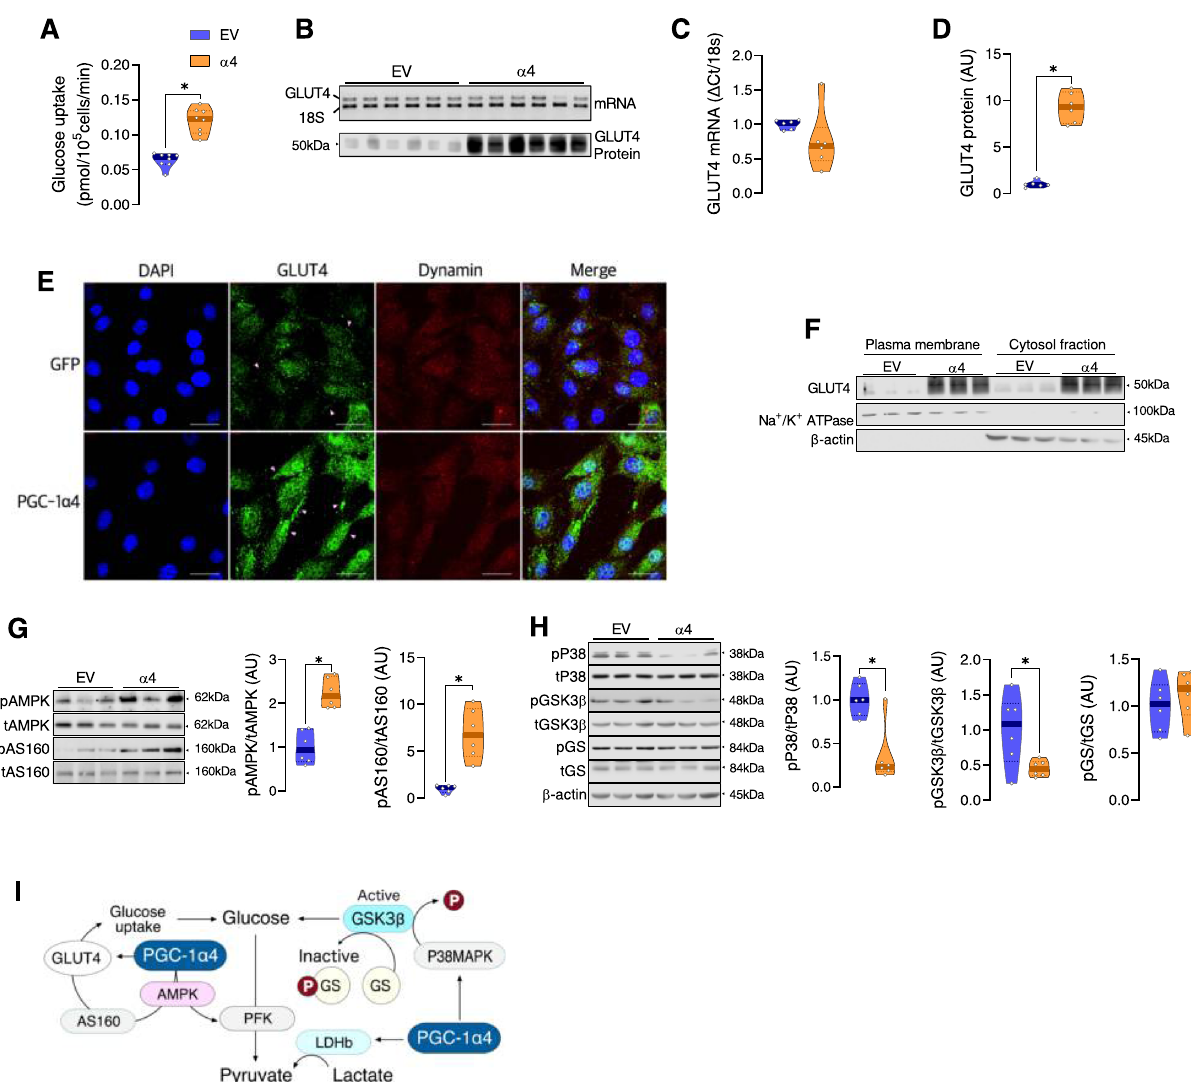
Fig. 4 PGC-1 α 4 overexpression enhances cellular glucose uptake. A Glucose uptake was assessed using a bioluminescent kit assay in myotubes transfected with an empty vector (EV) or an adenovirus overexpressing PGC-1 α 4 ( α 4) ( n = 8 per group). Unpaired two-tailed t -test was used. B – D GLUT4 mRNA was measured by semiquantitative RT-PCR, and GLUT4 protein content was measured by immunoblotting in myotubes expressing EV or overexpressing α 4 ( n = 6). Unpaired two-tailed t -tests were used. E GLUT4 antibody detection (green) and DAPI staining (blue) in cells transfected with EV or α 4 show clustering of greater GLUT4 near the dynamin-labeled (red) cell membrane in α 4 myoblasts. Experiments in panel E were repeated three times with similar results. White scale bars in each image are 30 µ m in length. F GLUT4 was measured in the plasma membrane (indicated by the presence of Na + /K + ATPase) and cytosolic (indicated by the presence of β -actin) fractions from myotubes transfected with EV or α 4 ( n = 3). G , H Representative immunoblots and quanti fi cation of phosphorylated AMPK, AS160, P38, GSK3 β , and GS in cells transfected with EV or α 4 are shown. Data are expressed as the phosphorylation of each signaling protein normalized to the abundance of its total protein content ( n = 6 per group). Unpaired two-tailed t -tests were used. I Diagram of the hypothetical role of PGC-1 α 4 in glucose metabolism in muscle cells. PGC-1 α 4 enhances signaling and transport machinery to bring glucose into the cell, as well as the glycolytic enzymes necessary for metabolizing glucose. Further, inhibition of key signaling events involved in glycogen synthesis by PGC-1 α 4 suggest a favorable role of PGC-1 α 4 in glycolysis. * P < 0.05 versus EV. Values are expressed as individual data points. Signi fi cant labeled P -values in each panel from left to right are as follows: panel A = < 0.001; panel D = < 0.001; panel G = < 0.001 and <0.001; panel H = 0.002 and